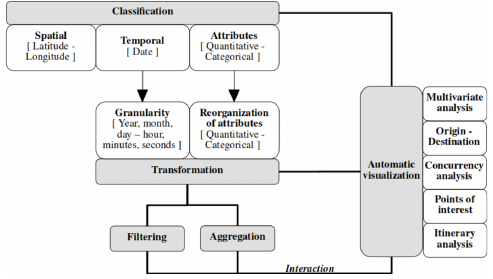
Figure 1. General structure of the solution implemented in the AVIMEU model.